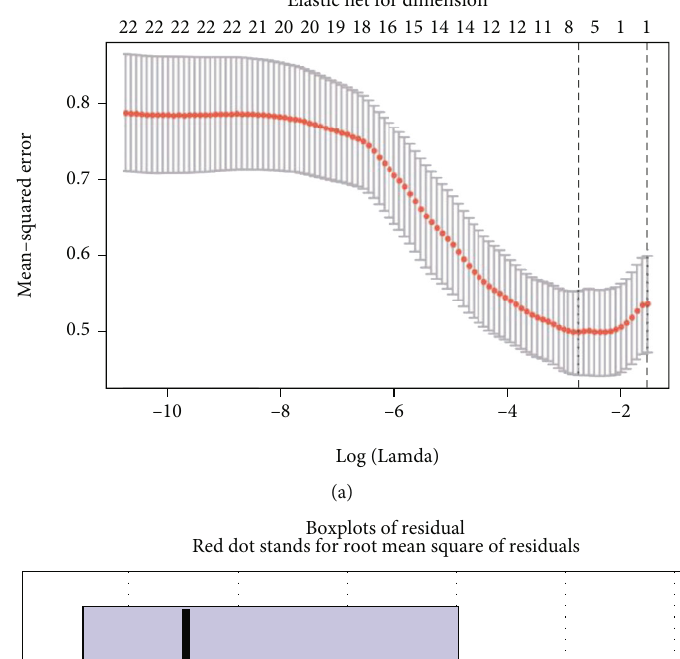
Boxplots of residual Red dot stands for root mean square of